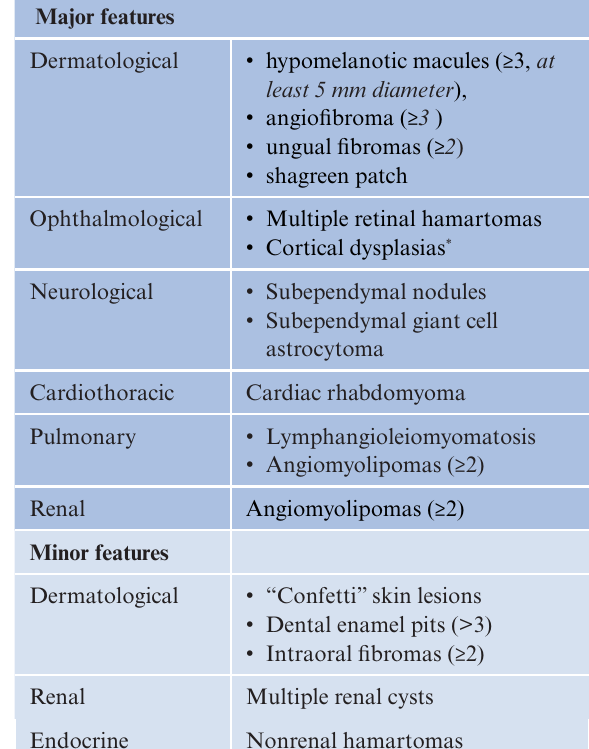
Table 3: Necessary features for diagnosing